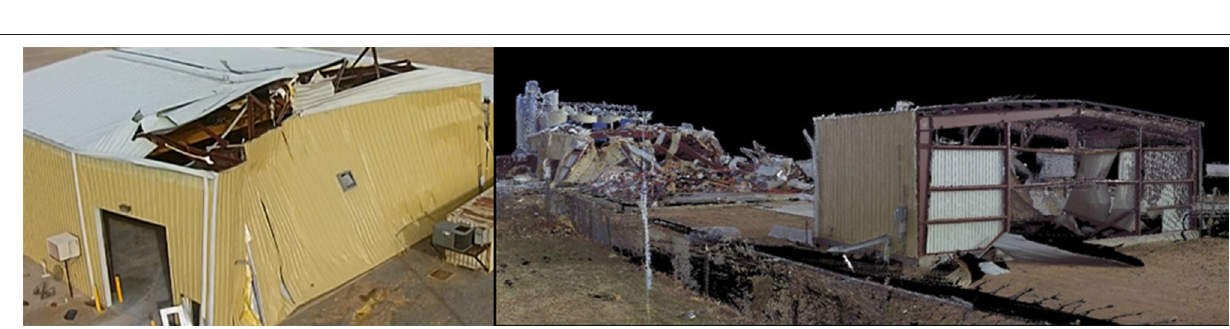
FIGURE 13 | UAS imagery (Left) and lidar point-cloud data of damaged Halliburton facility at Pampa, TX (Right) . (Image Credit: R. L. Wood/M. E. Ebrahim